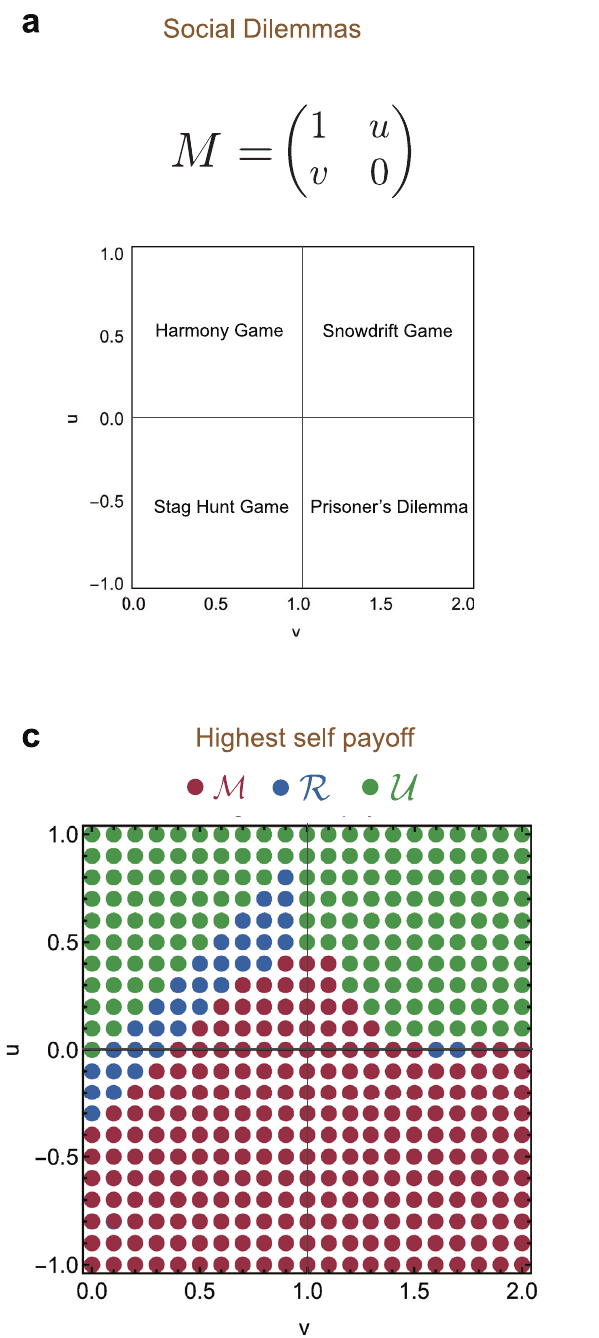
PLOS Computational Biology | https://doi.org/10.1371/journal.pcbi.1010149 June 14, 2022 14 /